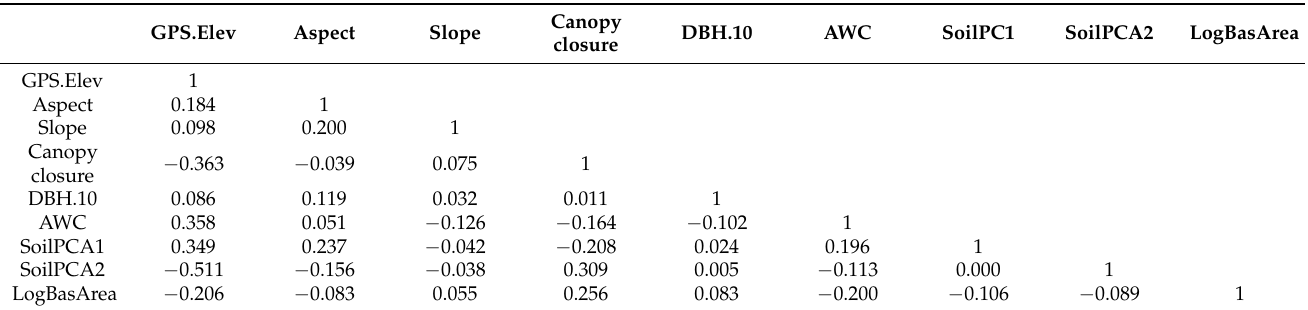
Table A3. Results from the Pairwise Pearson correlation coefficient among all variables, none of them has a values superior to 0.70 therefore we confirm that there is not collinearity between the factors included in the